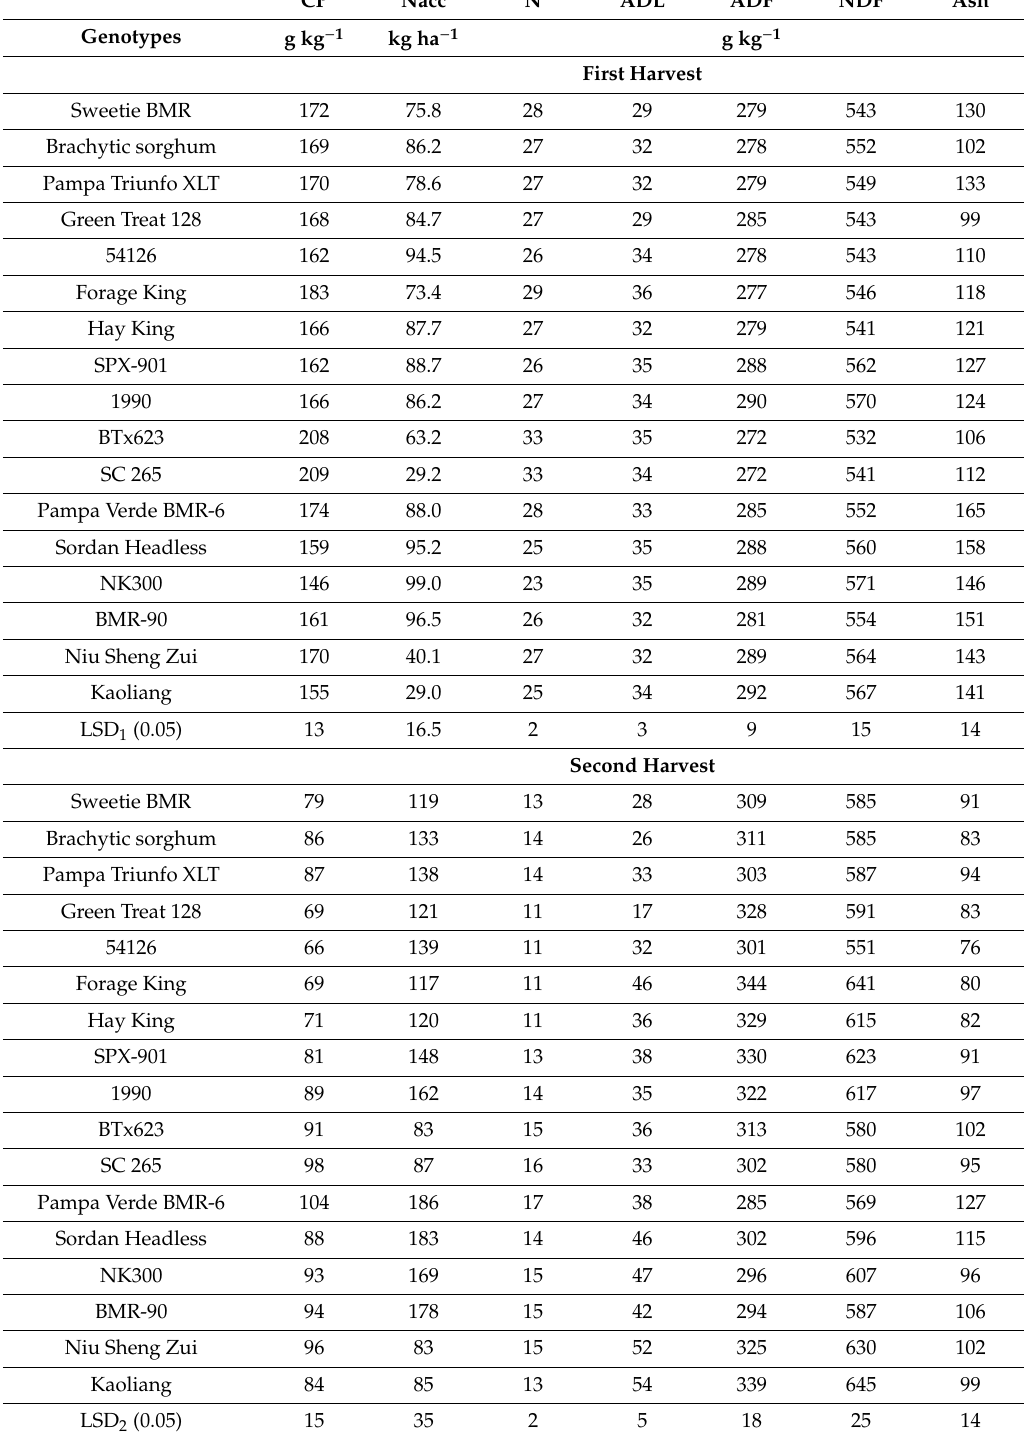
Table 4. Mean value of biomass quality in forage sorghum genotypes in the first and second harvest averaged across two seeding dates and four environments, Fargo and Hickson, ND, USA, in 2017 and